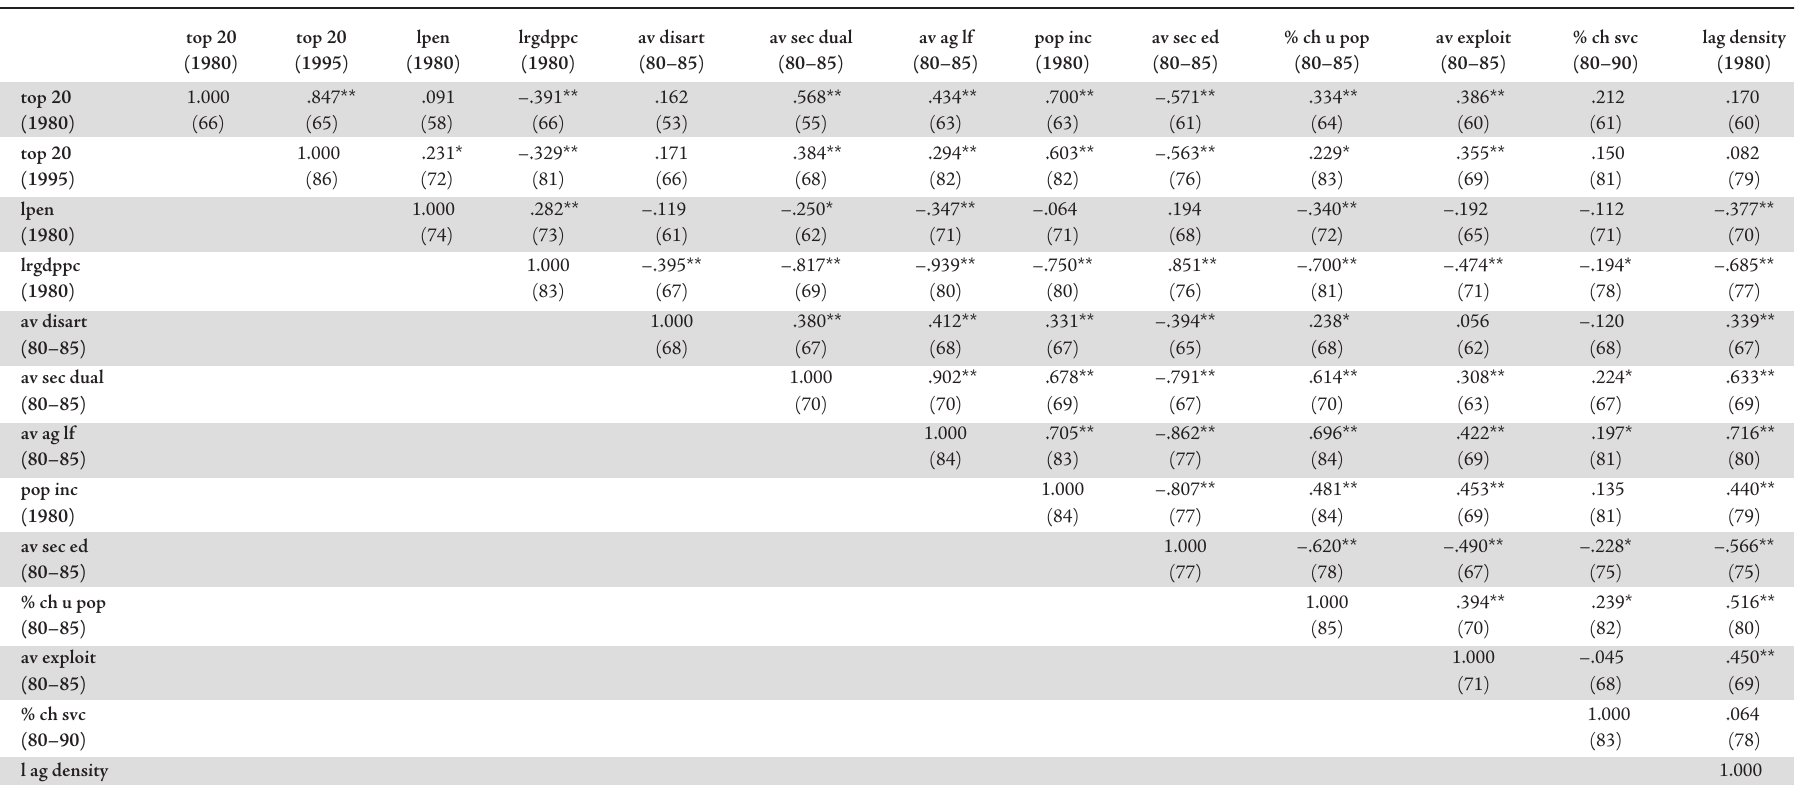
Table 2 – Correlation Matrix for Panel